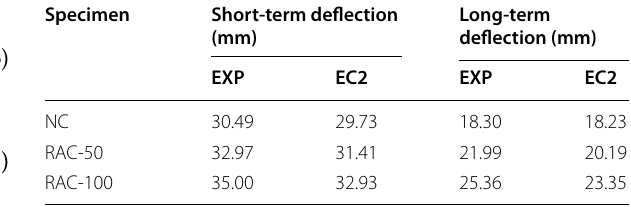
Table 6 Experimental values of beam